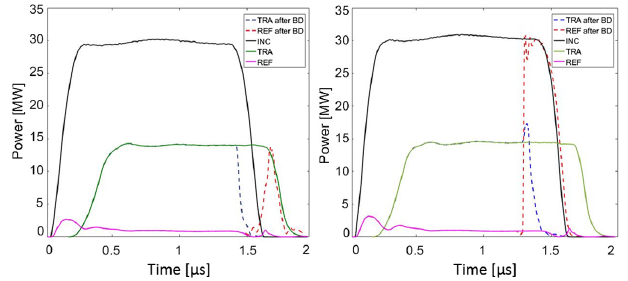
FIG. 12. A nominal incident (INC), reflected (REF) and transmitted (TRA) rf signals in the structure with comparison to a pulse after BD event with different reflection coefficient.